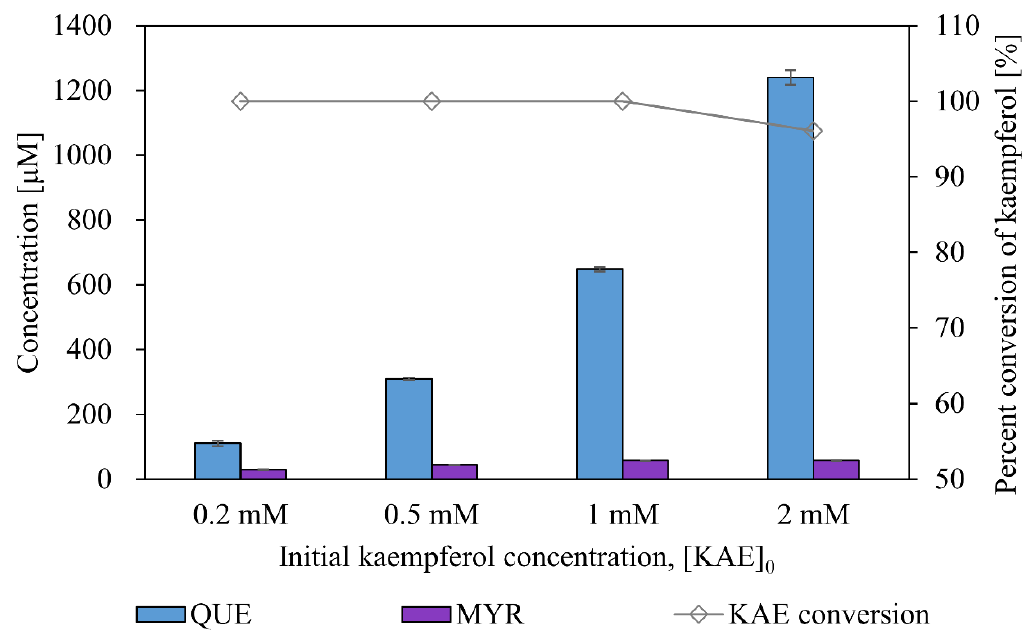
Figure 7. Conversion of kaempferol into quercetin (catechol) and myricetin (gallol) using Bm Ty. Purified Bm Ty (1 μM) was added to 200~2000 μM of kaempferol and conversion reactions were conducted at pH 6 and 37 ° C for 1 h. Concentrations of quercetin (blue bar) and myricetin (purple bar) were measured and substrate conversions were obtained from kaempferol concentrations (line with diamond labels).